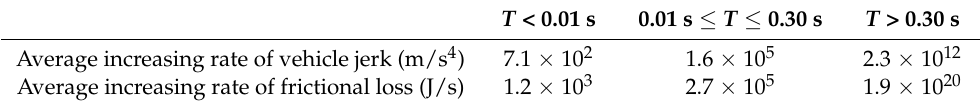
Figure 9. Evolution of the engagement performance with respect to the task scheduling period T . Table 3. Summary of the influence of the task scheduling period on the engagement performance.